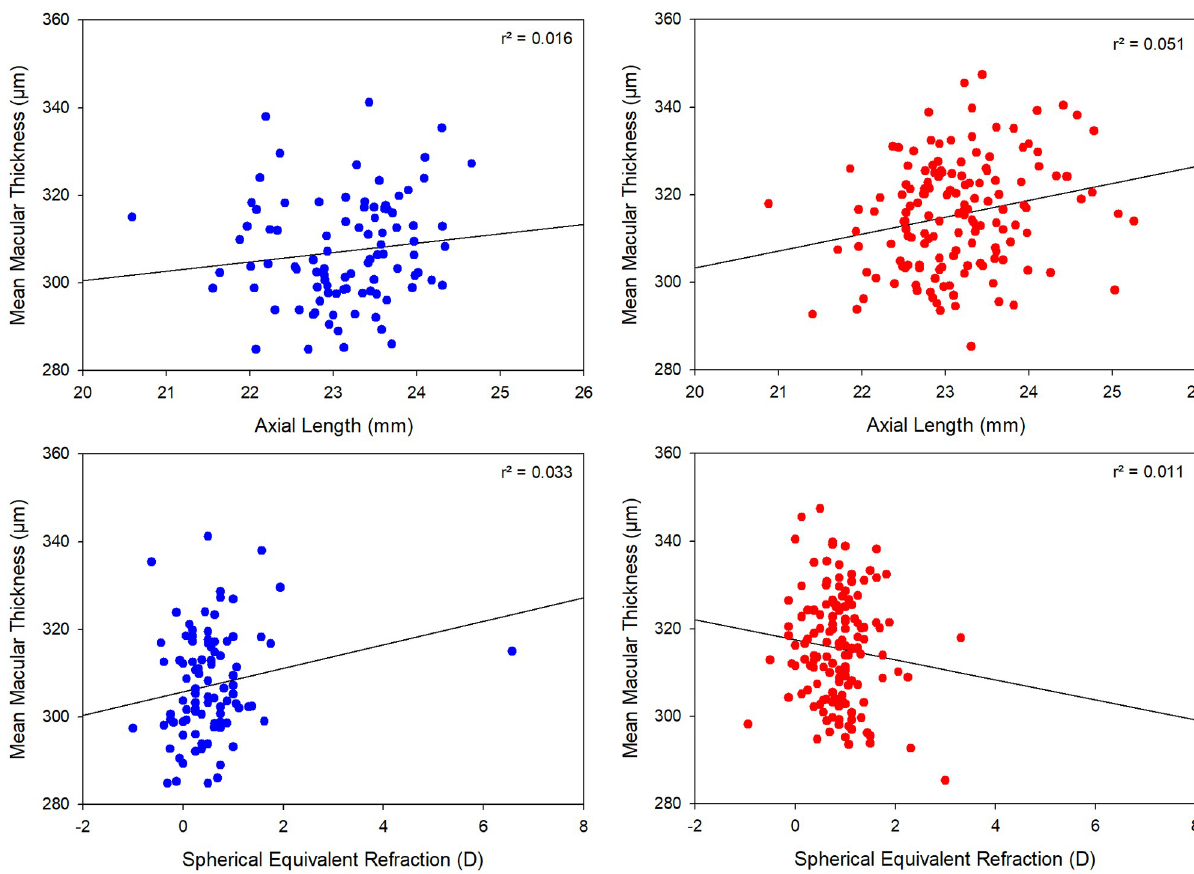
Fig 3. The relationship between the average macular retinal thickness and axial length (top) and between the average macular retinal thickness and spherical equivalent refraction (bottom) for Aboriginal and/or Torres Strait Islander children (left, blue symbols) and non-Indigenous children (right, red symbols).